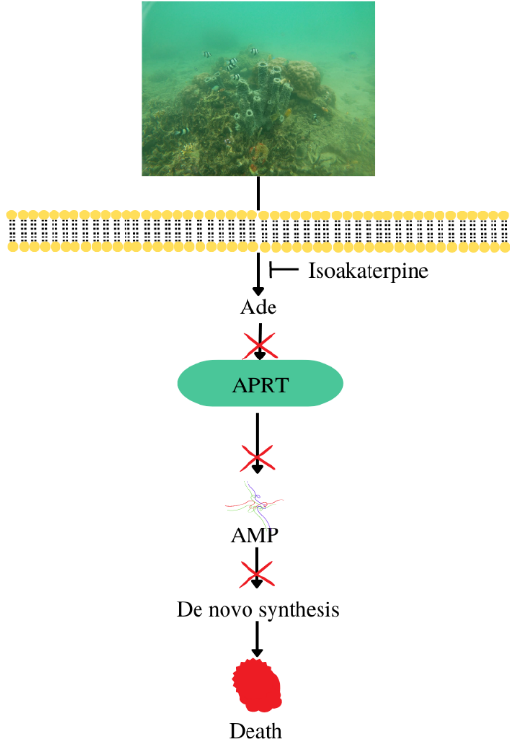
Figure 9. Antiparasitic mechanism of compounds from Callyspongia sp.